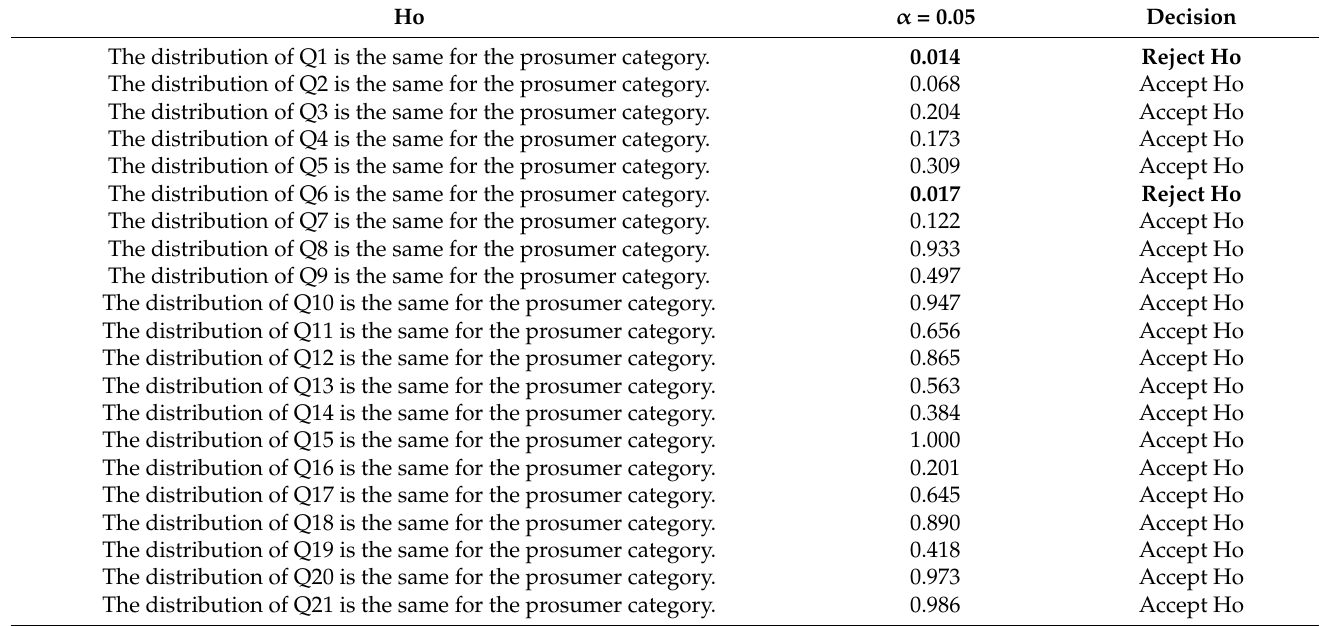
Table 4. Summary hypothesis test (Mann–Whitney U test for independent samples).